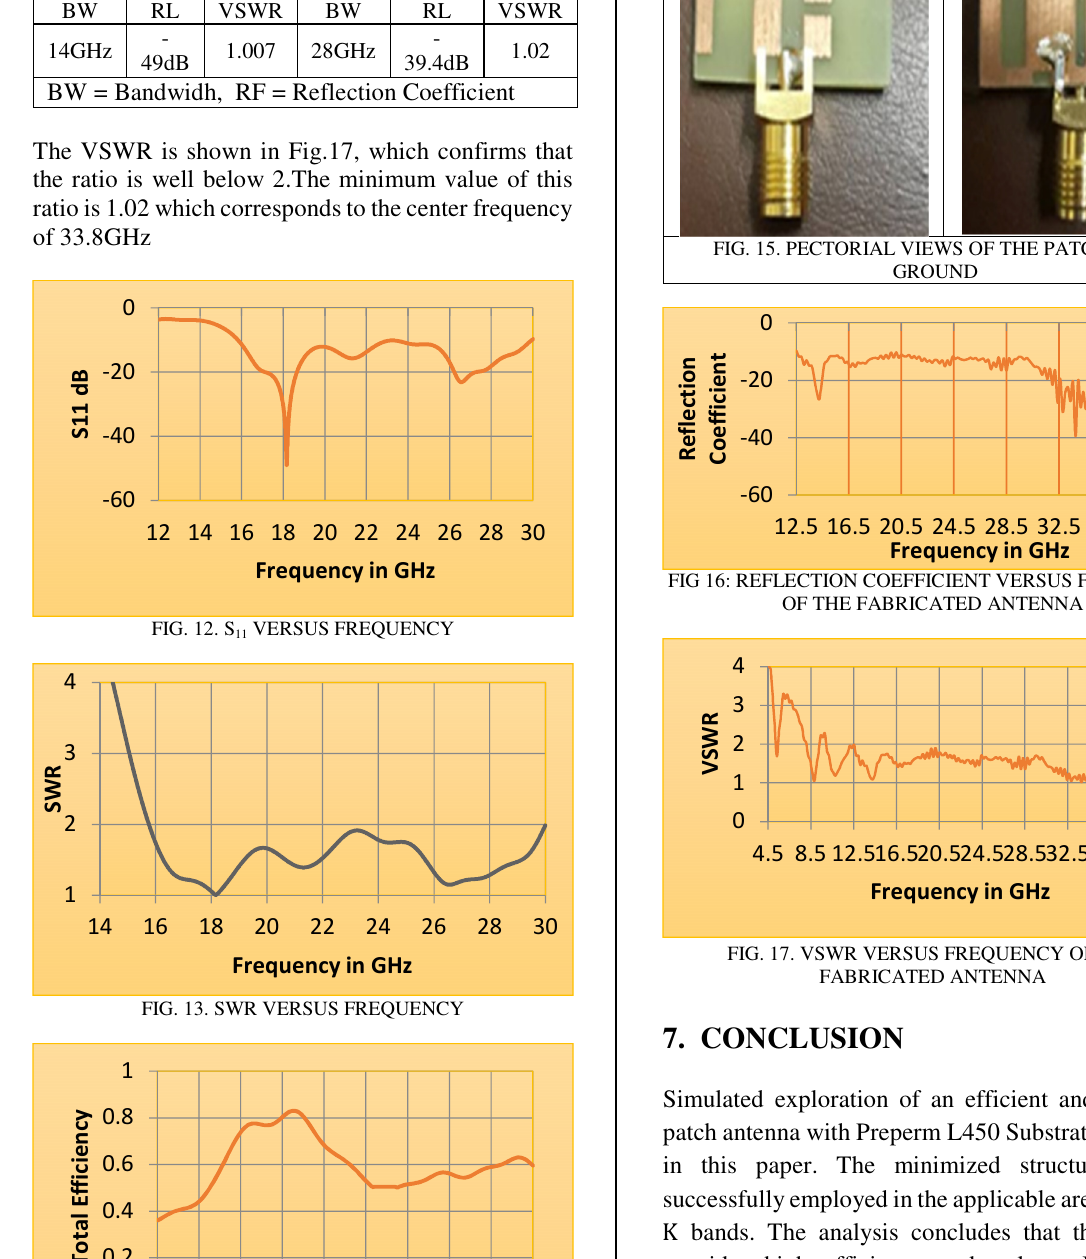
TABLE 4: RESUTS COMPARISON OF THE SIMULATED ANTENNA WITH THE FABRICATED DESIGN Simulated Antenna